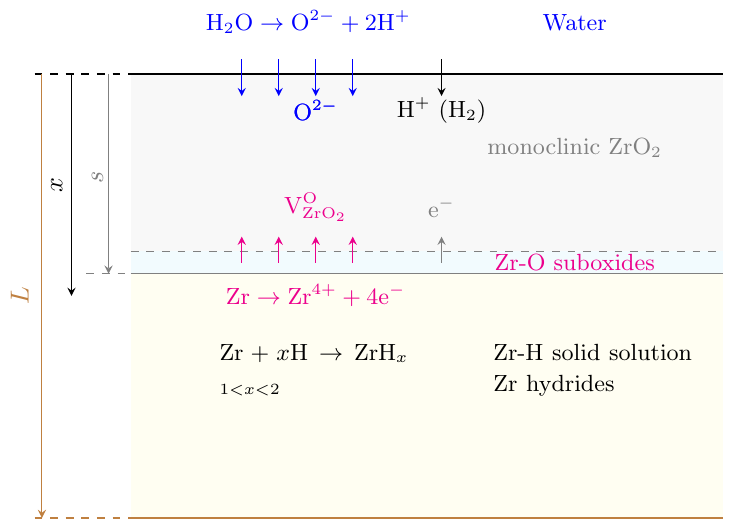
Figure 2. Schematic diagram (not to scale) of the geometry considered for the hydrogen penetration and hydride model developed in this work. x is the depth variable, s is the thickness of the oxide scale, and L is the total thickness of the clad. The chemical processes occurring at each interface are shown for